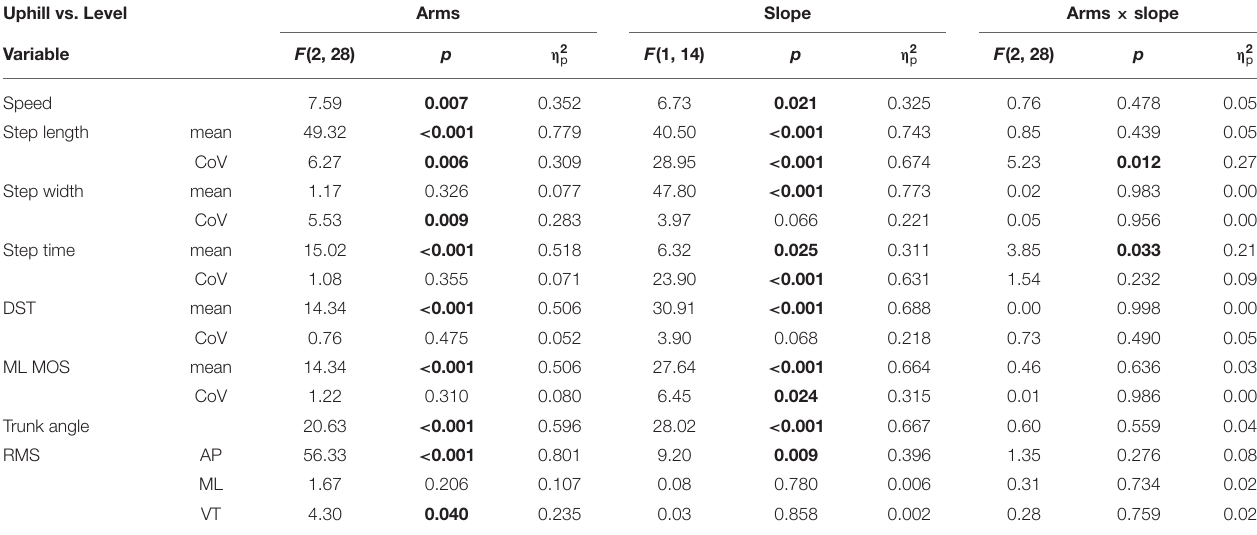
Boldfaced numbers indicate significant main effect.